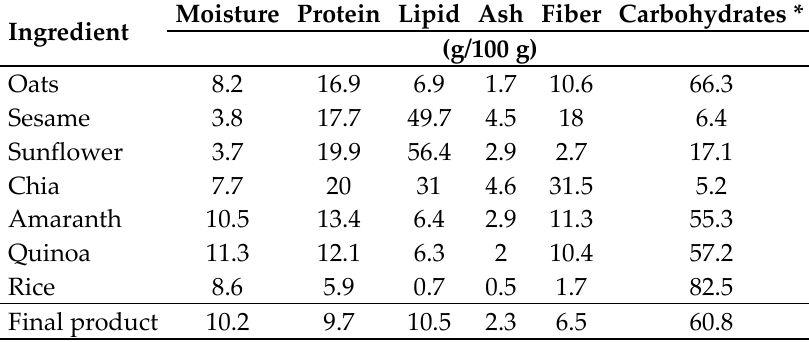
Table 3. Proximal composition of the selected ingredients and the final